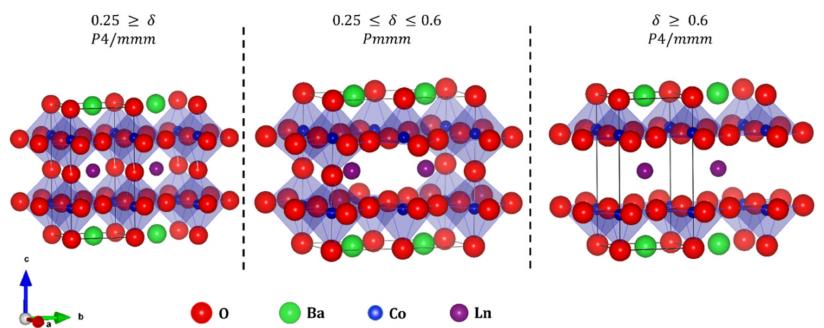
Figure 1. Unit cell of tetragonal ( P 4 / mmm ) and orthorhombic ( Pmmm ) BaLnCo 2 O 6- δ with the di ff erent oxygen content.